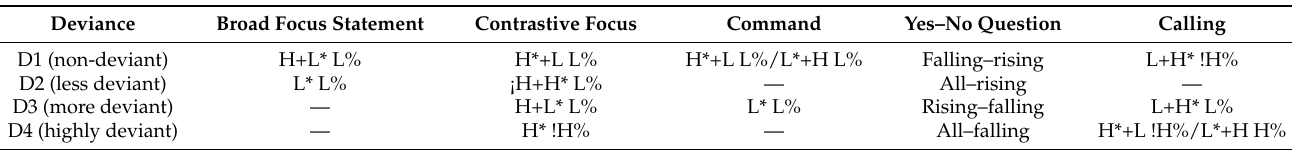
Table 3. Analysis of nuclear contours: definition of degrees of deviance relative to the prosodic grammar of the native language. Deviance